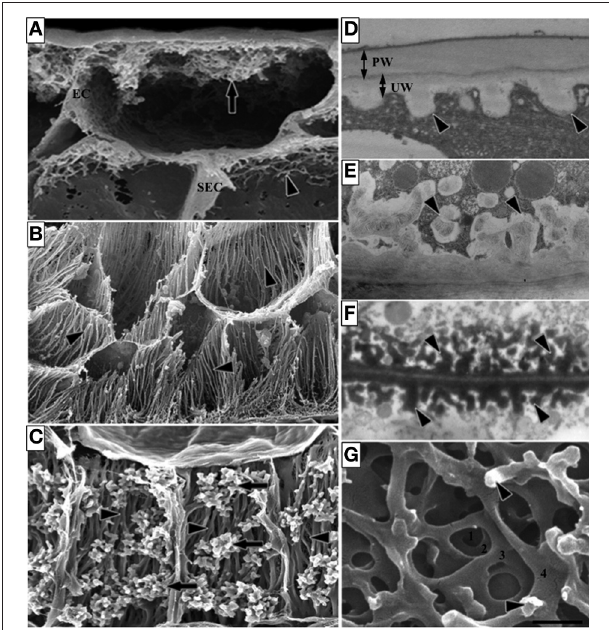
FIGURE 1 | Images of transfer cells of developing seeds during their storage phase illustrating ingrowth wall morphologies. (A–C) Scanning (A,B) and field emission scanning (C) electron microscope images of cells following freeze-fracture, removal of their cytoplasm and fixation [for method see Talbot et al. (2002)]. (A) Epidermal transfer cells (ETC) of a Vicia faba cotyledon with an extensive reticulate ingrowth wall labyrinth (arrow) polarized to the outer periclinal wall. Ingrowth wall deposition (dart) is restricted to wall portions abutting intercellular spaces adjacent to the sub-epidermal cells (SEC) [modified after Talbot et al. (2001)]. (B) Basal endosperm transfer cells of Zea mays exhibiting flange wall